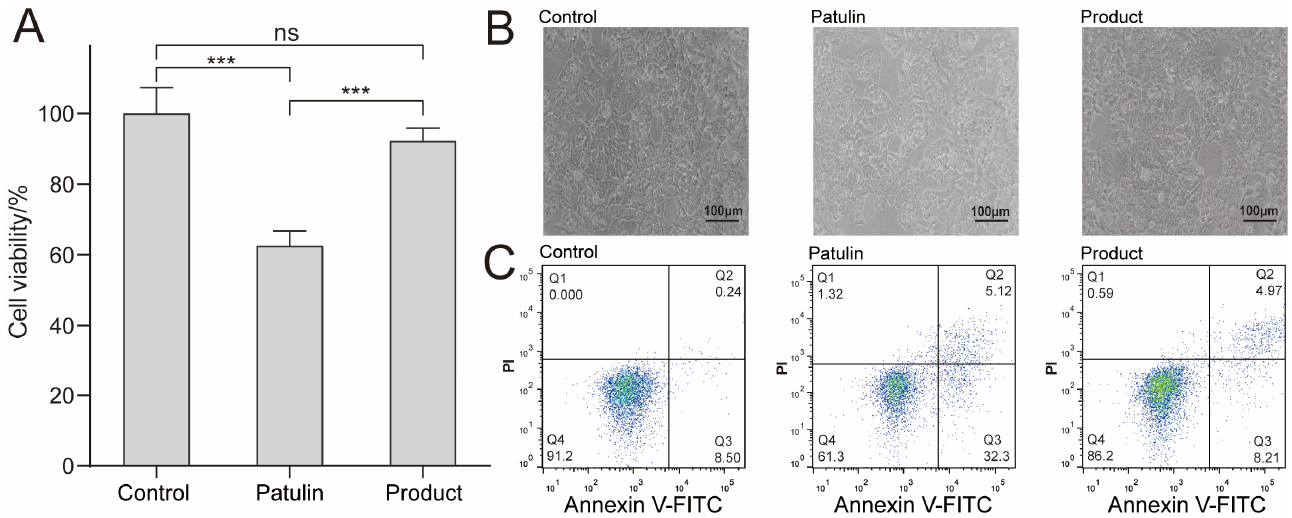
Figure 3. Effects of MEM (control group), patulin (treatment group), and patulin’s degradation products (product group) on the cytotoxicity and apoptosis of HepG2. ( A ) Cell viability measured by CCK8 method, where “***” means p < 0.001, and “ns” means no significant difference. ( B ) Cell morphology determined by an inverted microscope; the scale bar is 100 µ m. ( C ) The effect of Patulin and its degradation products on cell apoptosis. After FITC/PI staining, flow cytometry was used to detect cell apoptosis. The flow cytometry chart indicating the percentages of surviving cells, early apoptotic cells, late apoptotic cells, and necrotic cells; at least three samples were analyzed for each condition.